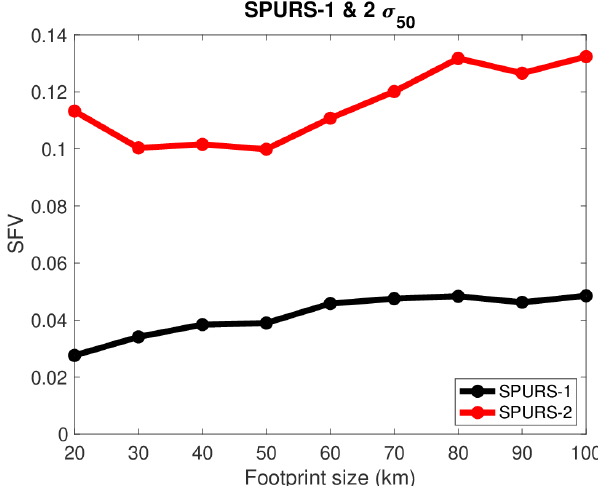
Figure 2. Median SFV ( σ 50 ) as a function of footprint size for SPURS-1 (black) and SPURS-2 (red) in situ data.